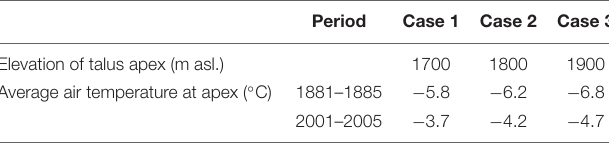
TABLE 3 | Thermal characteristics at the talus apex for Case 1–3 and Case 1–3 Control simulations.